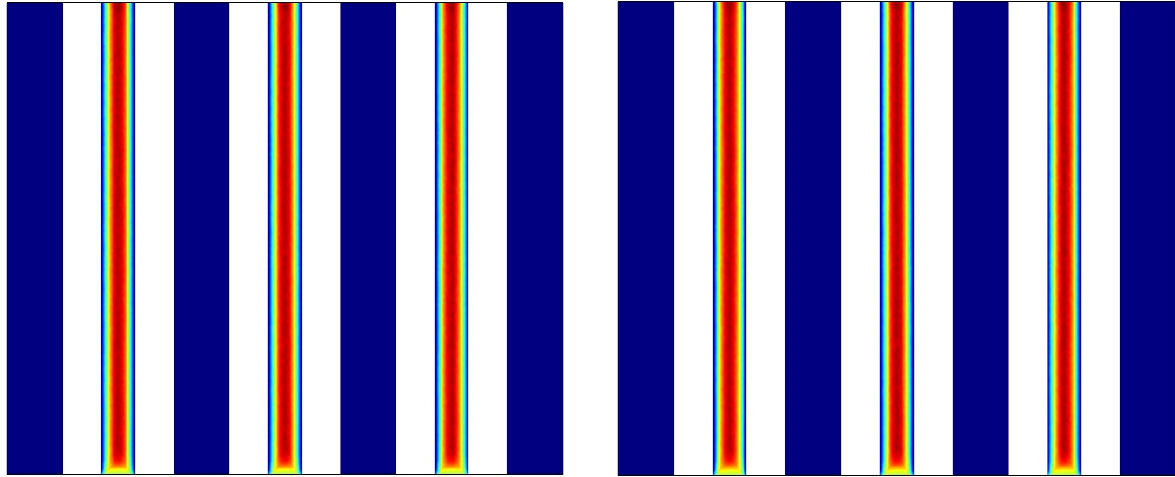
Figure 5. The average panel temperature at three velocities over time. Figure 6 indicates the velocity in the horizontal middle section at three velocities. A rise in the input velocity (flow rate) influenced the maximum velocity in the middle of the pipes. In addition, the average velocity increased as the input velocity increased. The ve- locity was almost zero in the PCM and around fins due to their rigidity. Due to the no-slip boundary condition, the velocity was low near the pipe wall and higher near the center- line. The flow velocity was maximized in the middle of the pipe. An increased input ve- locity may enhance the heat discharge through the flow.